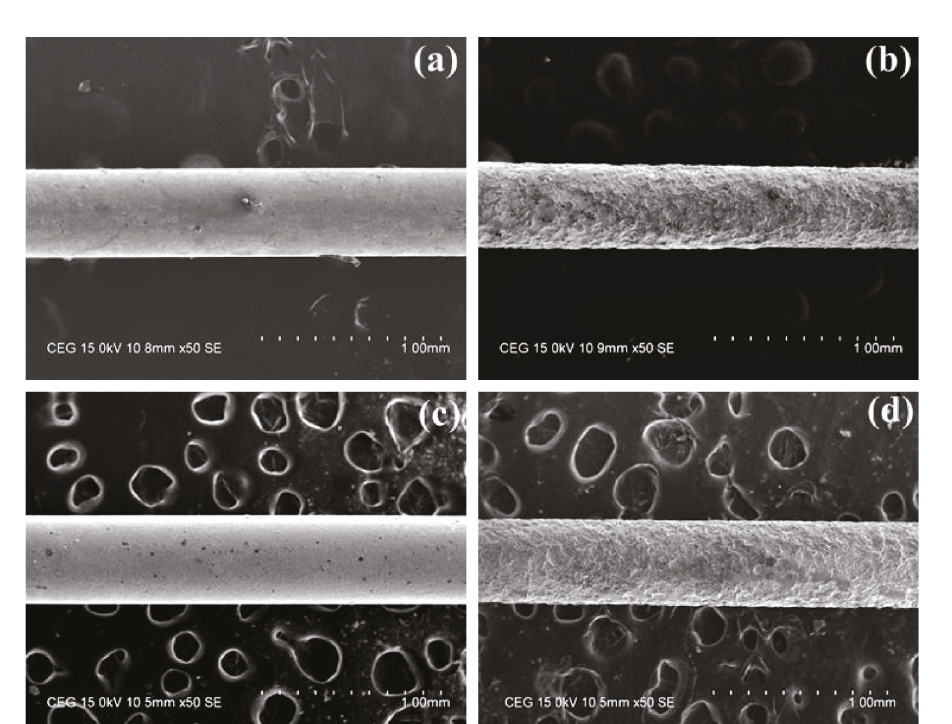
Figure 6: Residual plot for EWR.